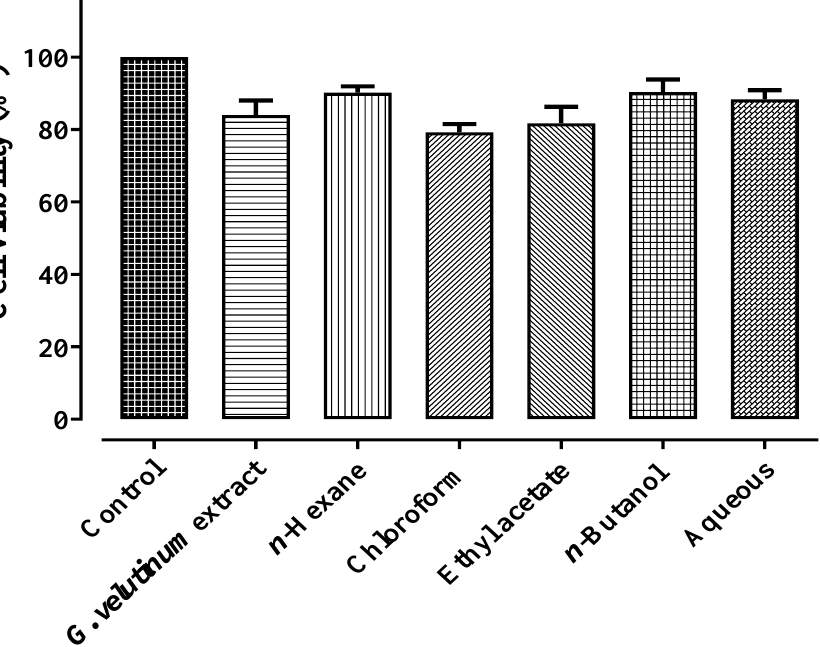
Figure 6. Presentation of growth inhibitory effects of G. velutinum extract and its fractions (at maximum tested concentration) against normal cells.